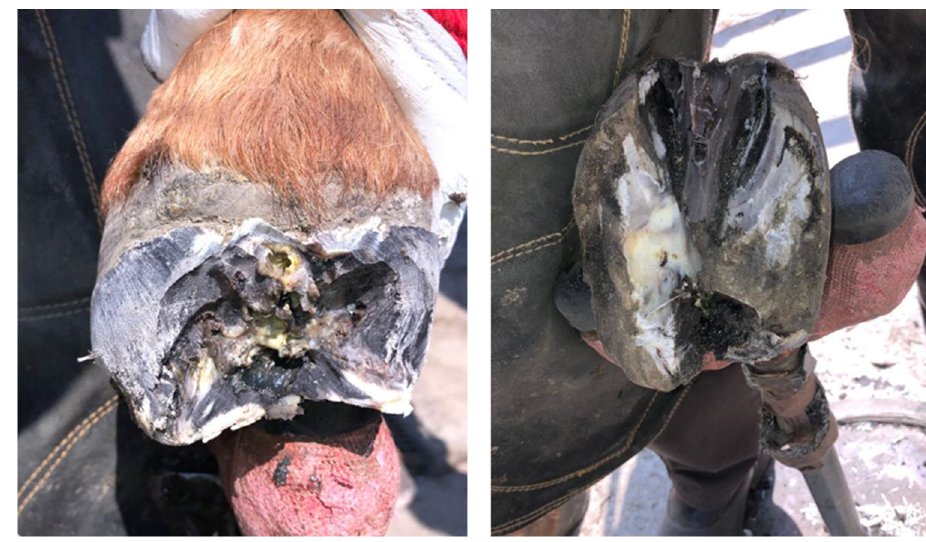
Figure 11. Hoof appearance during trimming 10 months after the third resection of the lesion. A black, irregular deformation is visible under the removed horn. The lysis of the coffin bone was also found.